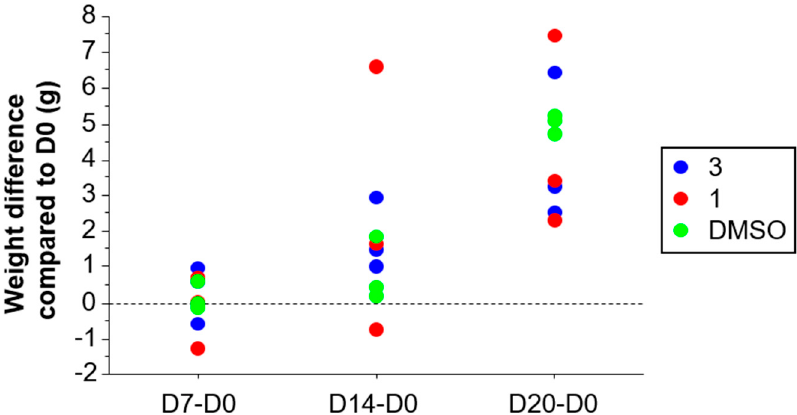
Figure 3. Acute toxicity of Compounds 1 and 3 in healthy Swiss mice. Mice ( n = 3 per group) were daily treated on D0 to D3 intraperitoneally with 50 mg / kg of Compounds 1 and 3 or their vehicle (50% DMSO). Mice were clinically monitored during 20 days. Results are presented by the di ff erence in weight between the day of follow-up and D0. Weight di ff erences were compared between groups at each point by the Kruskall–Wallis test, p >